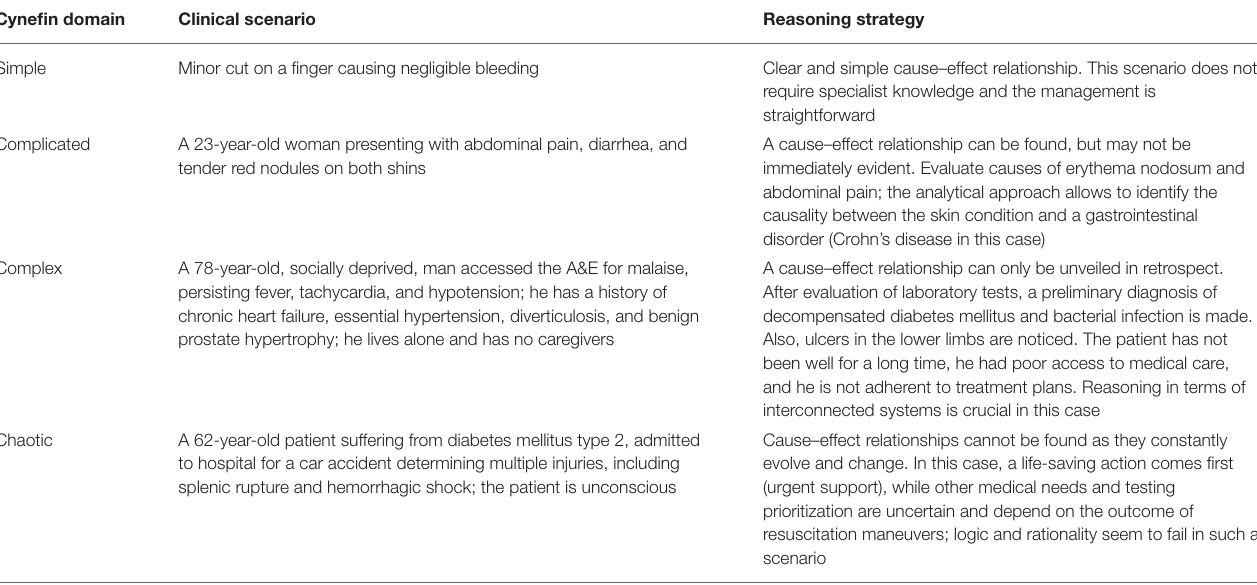
TABLE 1 | Examples of different clinical scenarios categorized according to the Cynefin framework. Cynefin